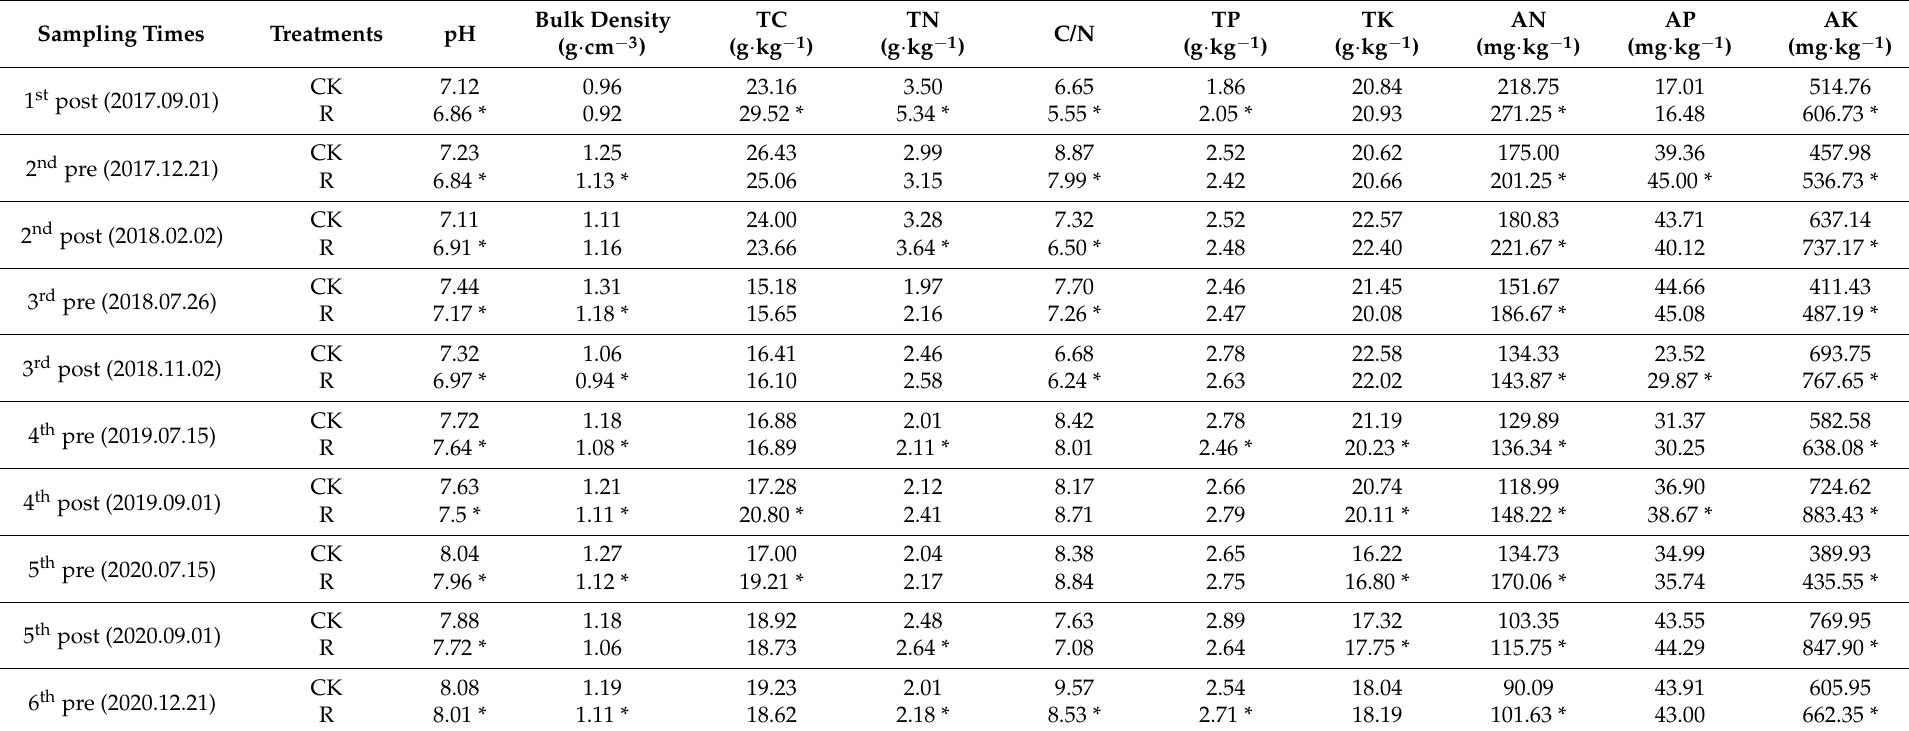
Table 2. The soil physicochemical